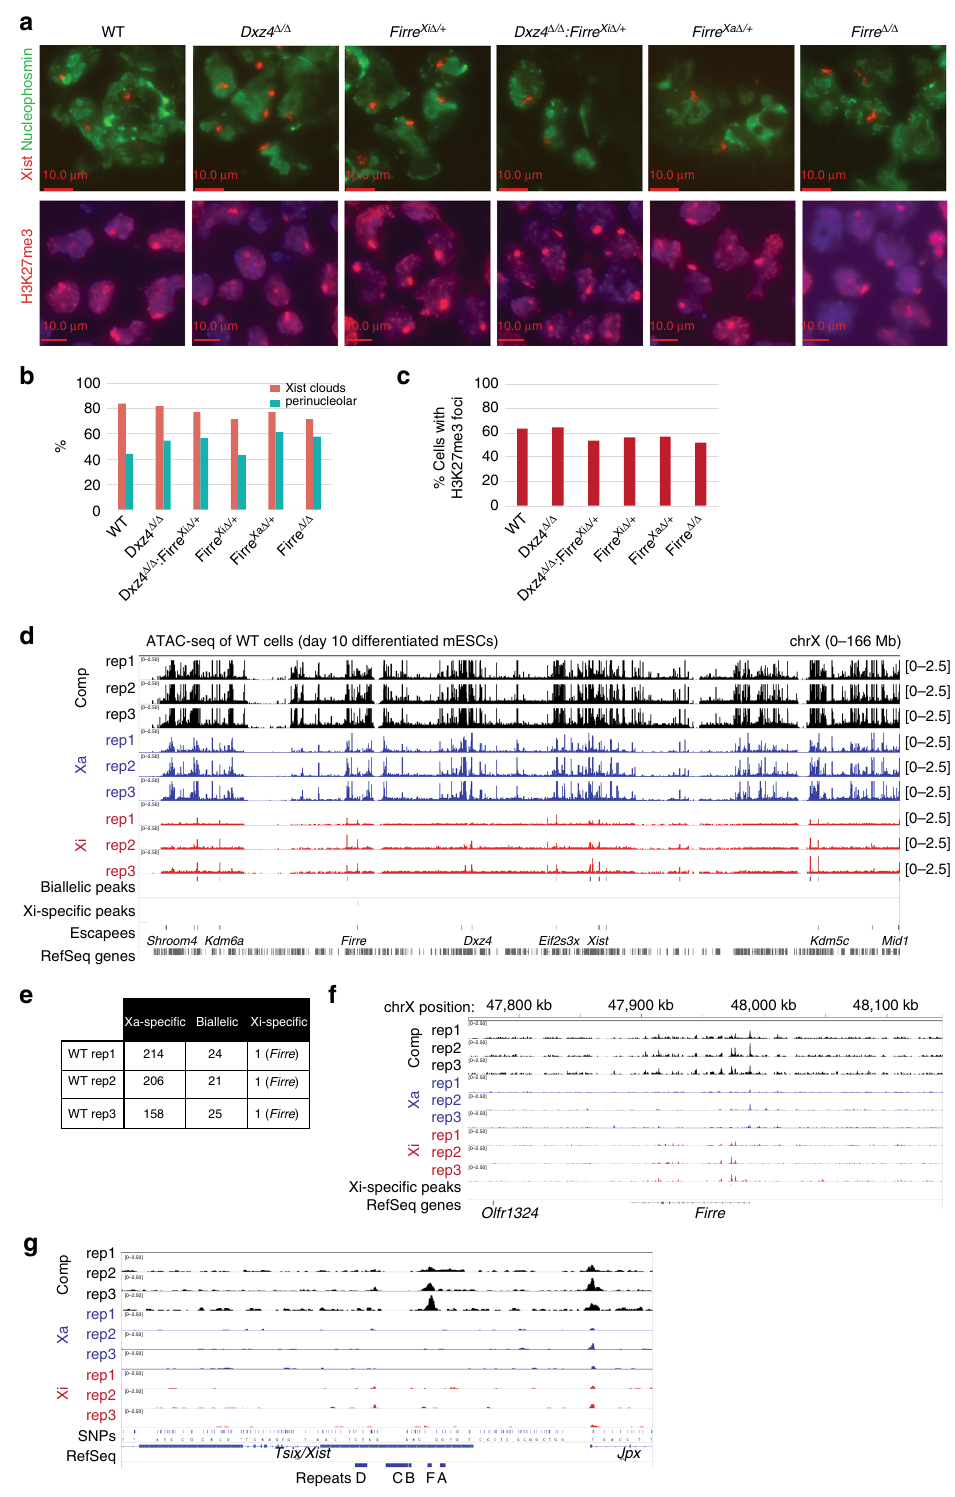
Fig. 7 Dxz4 and Firre do not affect Xi localization and accessibility. a Xist RNA FISH (red) combined with nucleophosmin immuno fl uorescence (green) (top) and H3K27me3 IF (bottom) in wild-type, Dxz4 Δ / Δ Firre Xi Δ / + , Dxz4 Δ / Δ : Firre Xi Δ / + , Firre Xa Δ / + and Firre Δ / Δ cells. Scale bars: 10 μ m. b Fraction of cells with Xist clouds (red) and fraction of Xist clouds in the perinucleolar space (cyan). c Fraction of cells with an H3K27me3 focus. d ATAC-seq coverage across the X (all unique reads, black), Xa (blue) and Xi (red) in wild-type cells, 3 biological replicates. e Allelic status of ATAC peaks in wild-type cells. f ATAC- seq coverage in WT over Firre . g ATAC-seq coverage across Xist . Xist also demonstrates an ATAC peak, consistent with its expression in female cells. The lack of SNPs precluded allele-speci fi c